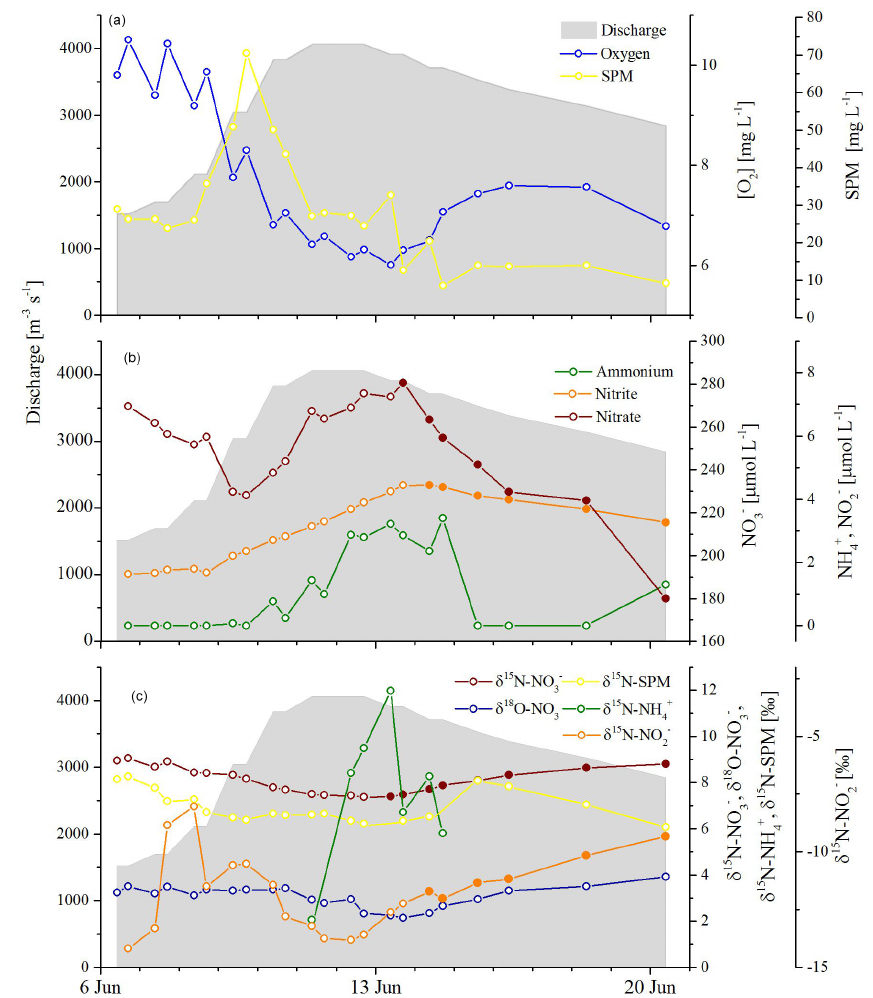
Figure 1. (a) Discharge, dissolved oxygen concentration, and SPM concentration of the Elbe River water samples from 6 to 20 June 2013. Flood conditions occur with discharge >3000m 3 s − 1 . (b) Ammonium, nitrite, and nitrate concentrations in the Elbe River in the course of the flood. Calculation of the fractionation factor is based on filled data points. (c) Ammonium, nitrite, nitrate, and SPM isotope values in the course of the flood. Calculation of the fractionation factor is based on filled data